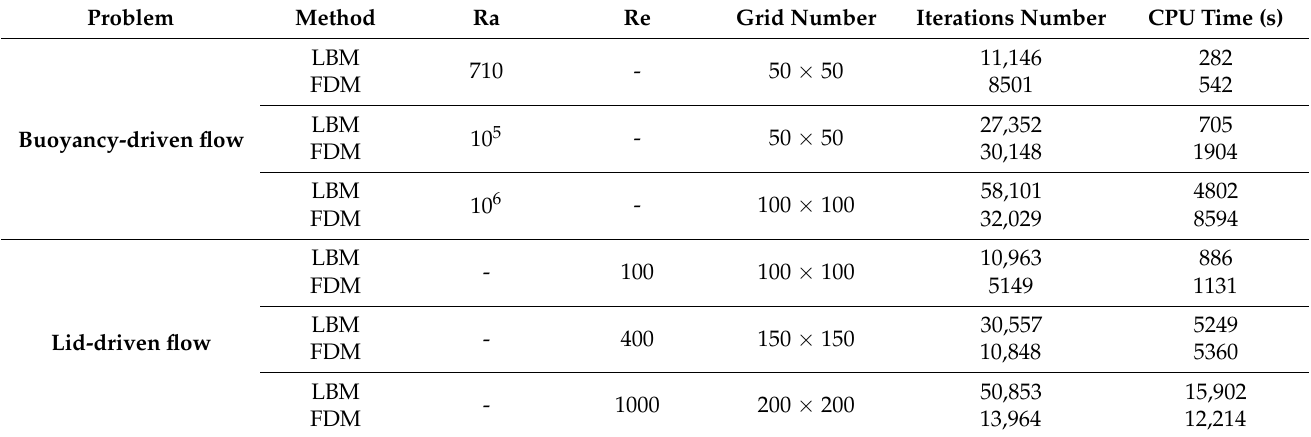
Table 8. Comparison between LBM and FDM in cases of buoyancy-driven cavityand lid-driven cavity flows